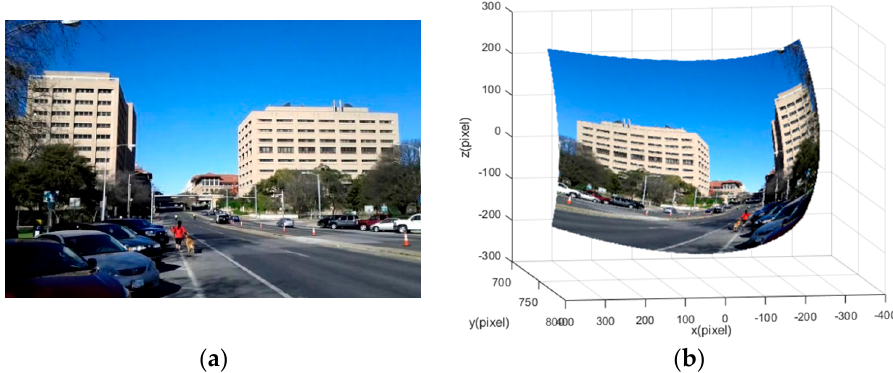
Figure 4. Example of spherical projection: ( a ) two-dimensional (2D) image; ( b ) spherical projection image.